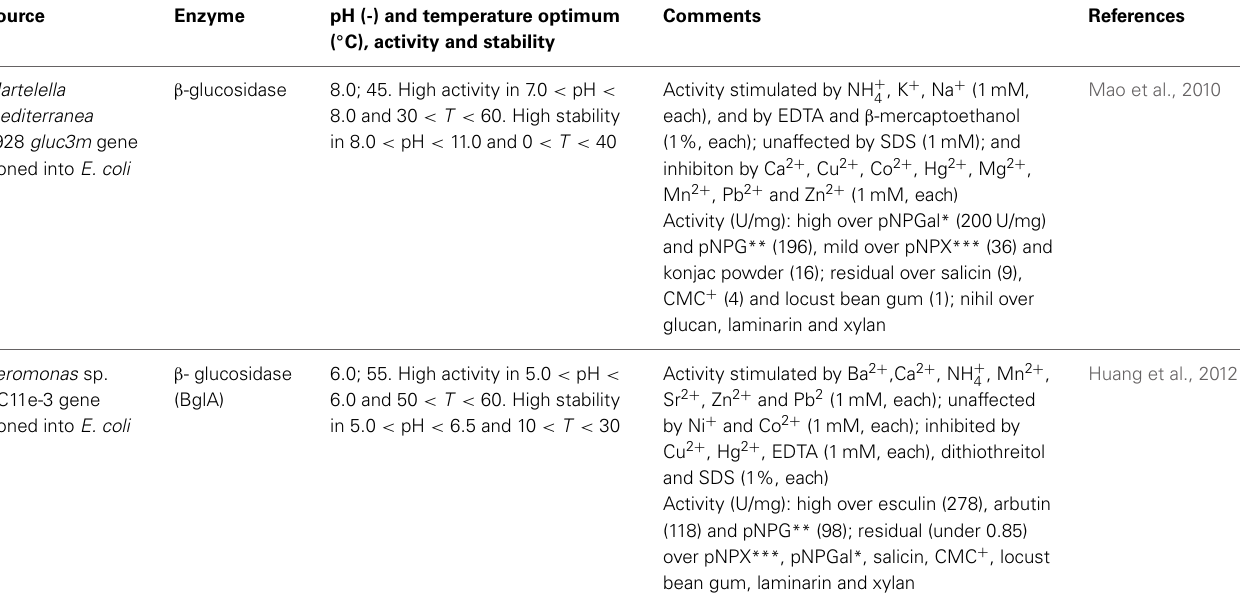
hydrolysis can thus be performed in such alkaline environment, since unwanted color formation was ruled out at this temper- ature, only at 65 ◦ C and pH at least 10 was a slight yellow color observed after 4 h of operation (Li et al., 2012). Alkali- tolerance (pH optimum of 8.0, and activity within pH